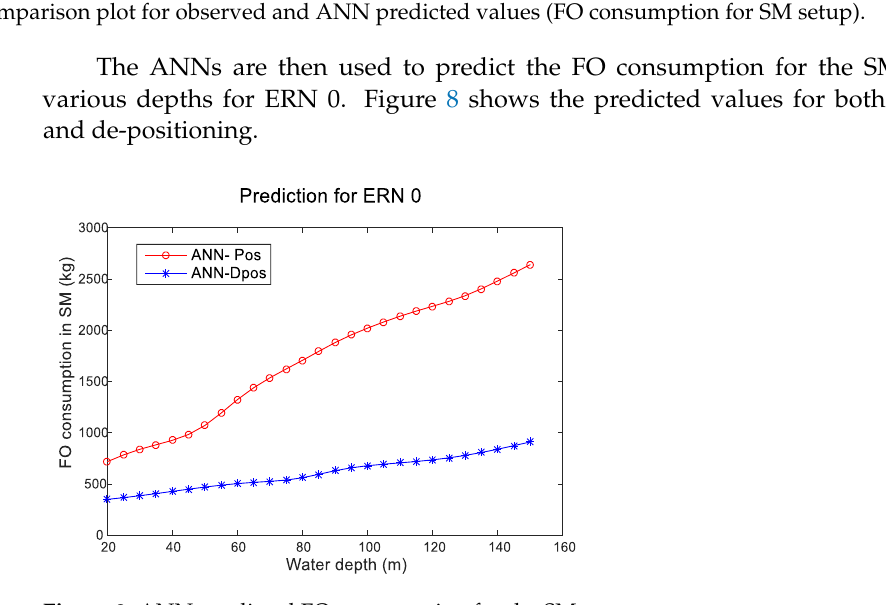
Figure 8. ANN-predicted FO consumption for the SM system.